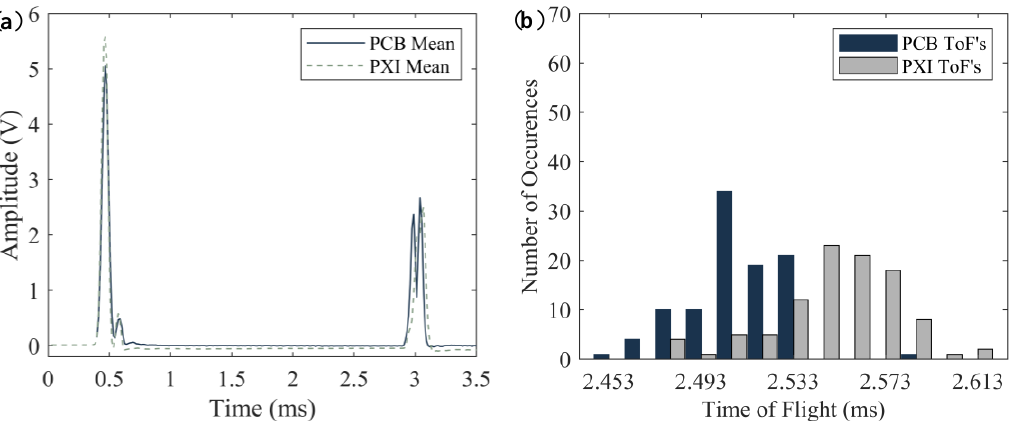
Figure 12. Foam board test. ( a ) time-series obtained by averaging the 100-time waveforms measured with the sensor disks. ( b ) Number of occurrences of a given ToF. For each color, the total number of occurrences is 100.